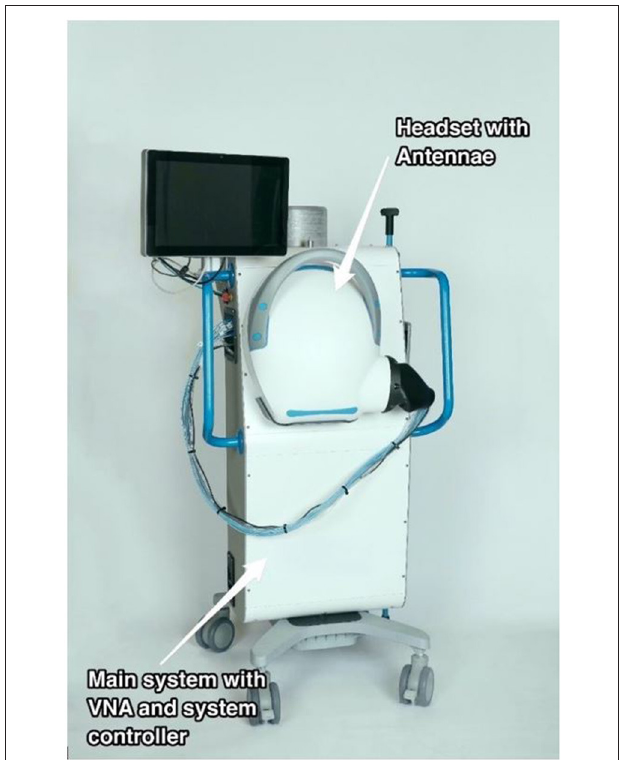
FIGURE 1 | Clinical prototype electromagnetic head scanner.